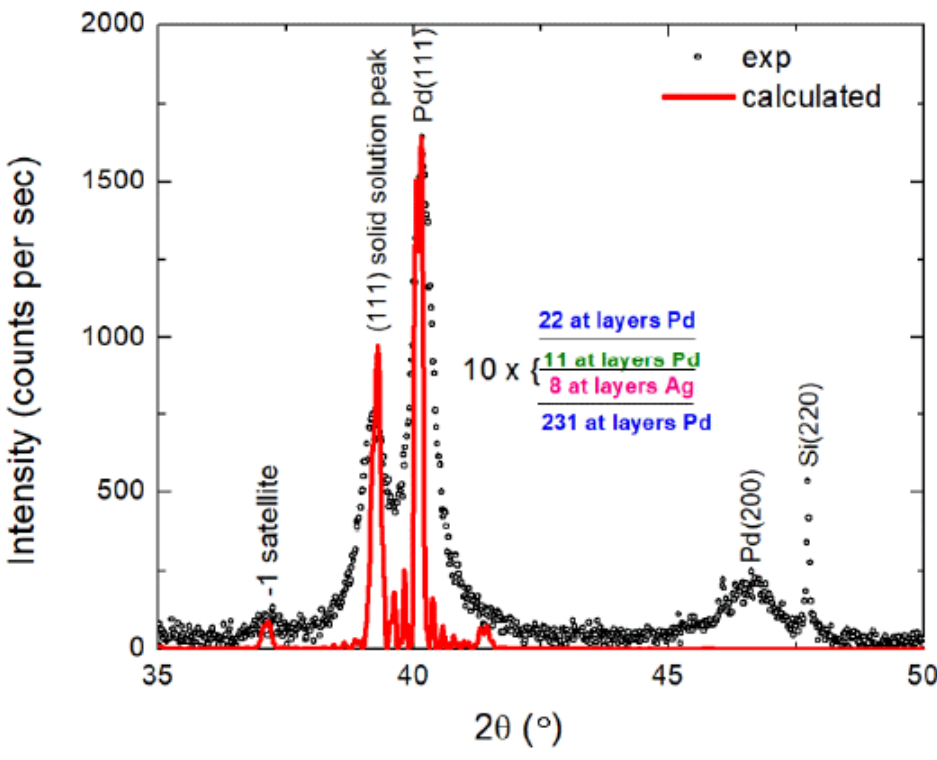
Figure 1. Experimental and calculated high-angle XRD pattern of an Ag/Pd multilayer grown over a relatively thick Pd buffer layer and capped by a thin Pd layer. This sample was grown on a Si (100) wafer to minimize the noise in the XRD pattern. The Pd diffraction served as a ruler for the accurate determination of the angular position of the diffraction peak of the multilayer. This, together with the position of the first-order satellite diffraction were necessary for the accurate (within 5%) determination of the Pd concentration and the thickness of the individual Ag and Pd layers in the number of atomic (at) layers as indicated